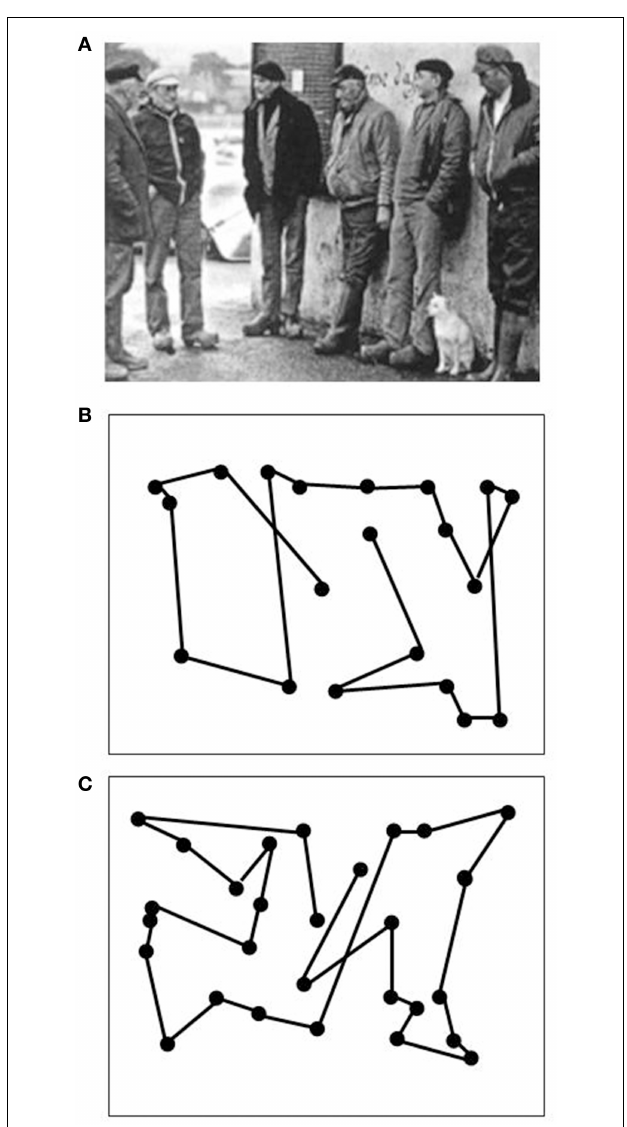
FIGURE 1 | Oculomotor scanning patterns during the inspection of a scene (A) in an age-matched normal subject (B) and in LM (C). Dots indicate fixation positions, lines saccadic eye shifts. Both subjects reported all relevant items. Scanning time was 13.6s for the normal subject and 26.6s for LM. Note similar correspondence of scanning patterns to the spatial configuration of the scene in both subjects.